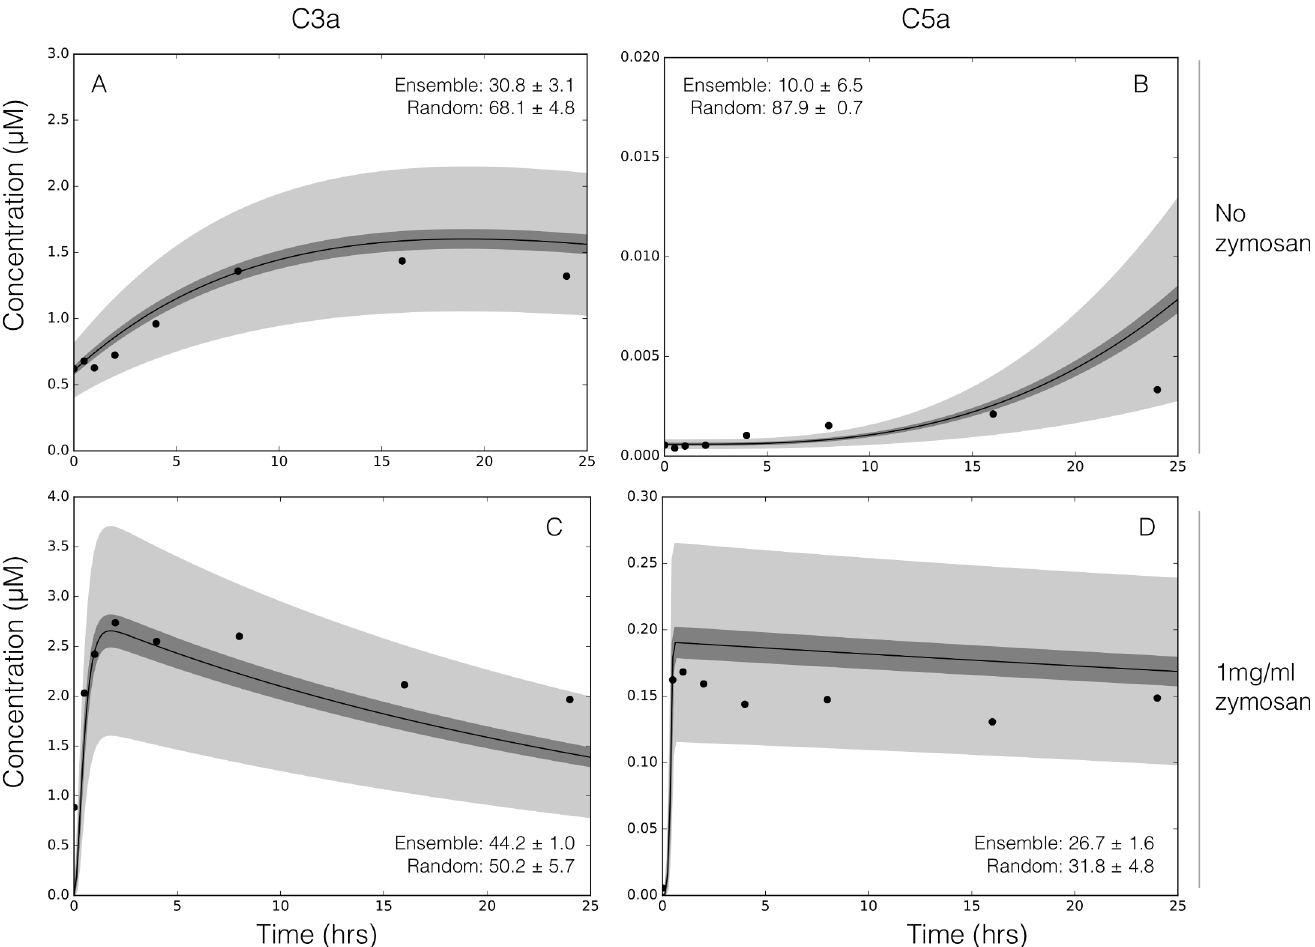
Fig 2. Reduced order complement model training. An ensembleof model parameters was estimated using multiobjective optimizationfrom dynamic C3a and C5a measurements with and without zymosan. The model was trained using C3a and C5a measurements in the absenceof zymosan ( A – B )or in the presenceof 1 mg/ml zymosan ( C – D ).The solid black lines show the simulatedmean value of C3a or C5a for the ensemble,while the dark shaded regiondenotes the 99% confidenceinterval of mean. The light shadedregiondenotes the 99% confidenceinterval of the simulatedC3a and C5a concentration. The experimental trainingdata (points) was taken from Morad et al [35]. All initial conditions not specifiedby the experimental condition were assumed to be at zero or their physiological serum levels unless otherwisenoted (S1 Table).